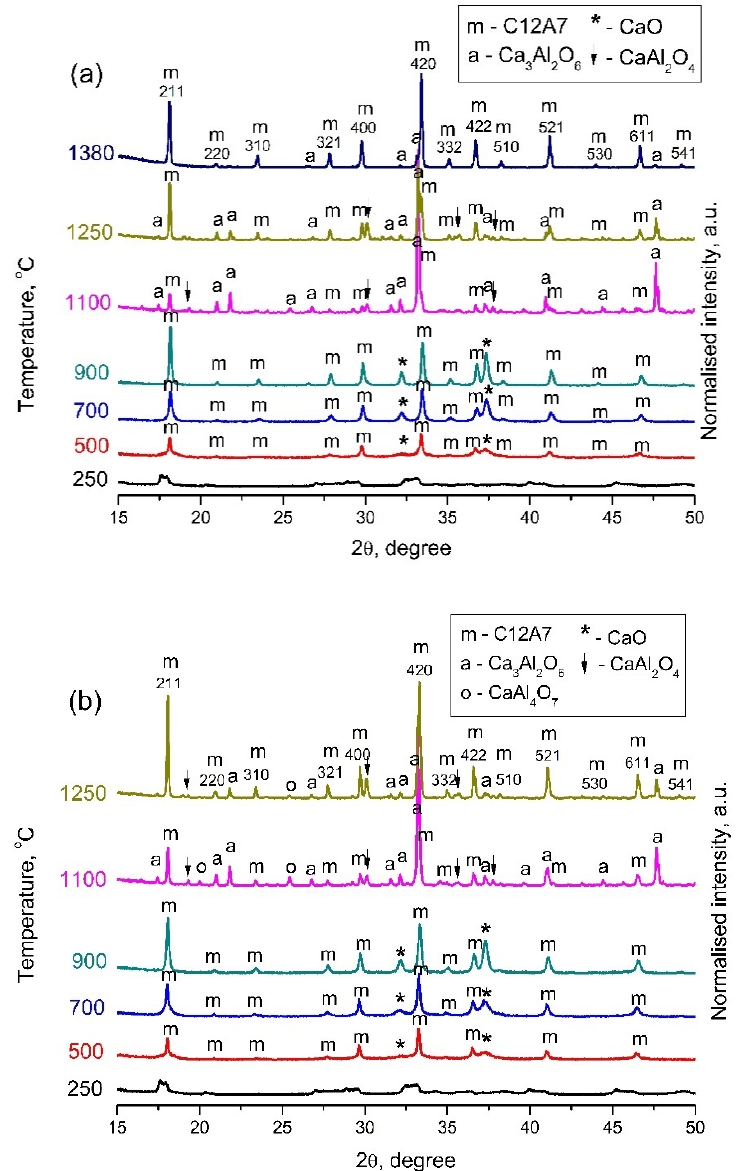
Figure 1. Diffraction patterns of samples obtained in inert Ar atmosphere ( a ) and in air ( b ) at different temperatures.